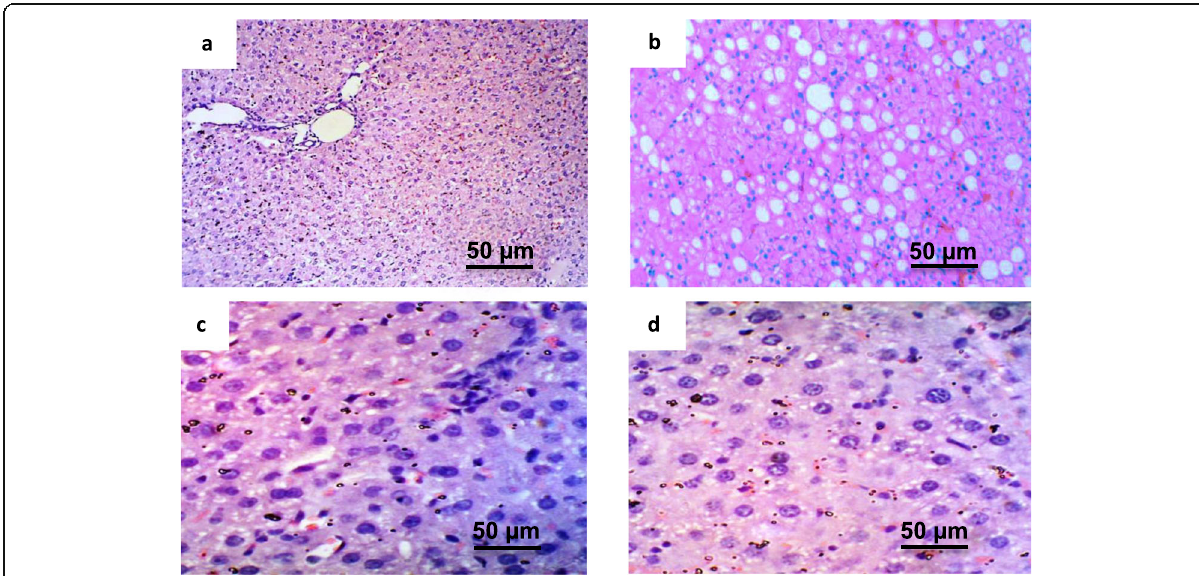
Fig. 6 Histology of liver tissue of experimental rats; a : Normal Diet fed rat liver without fatty droplets; b : HFD fed obese rat liver with larger fatty droplets; c : AEAA (300 mg/kg bw) treated obese rat liver with very few fatty droplets; d : Standard Drug (Orlistat) treated obese rat liver showing reduced fatty droplets